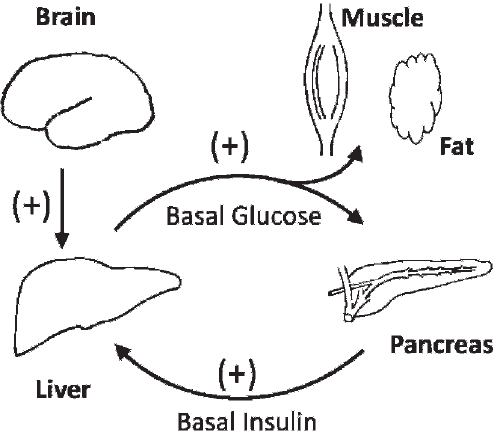
Figure 7 - A diagram showing the possible targeting sites of mibefradil on the system regulating basal glucose. ( + ),